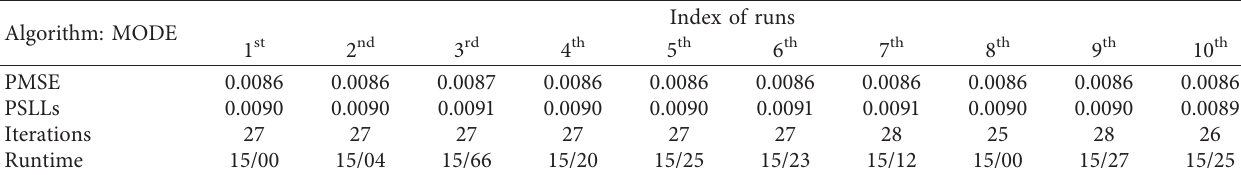
Table 5: Performance of MODE in 10